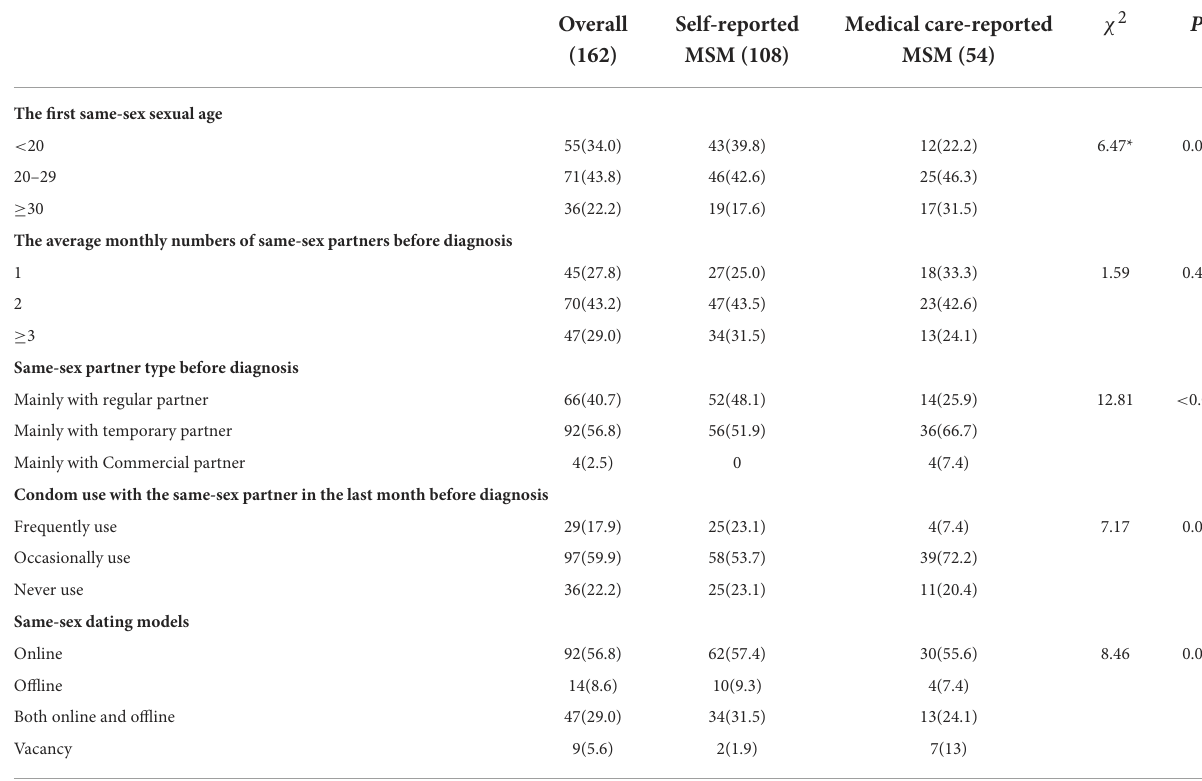
TABLE 2 Same-sex behaviors and dating models among pMSM self-reporting having happened same-sex behavior in the survey